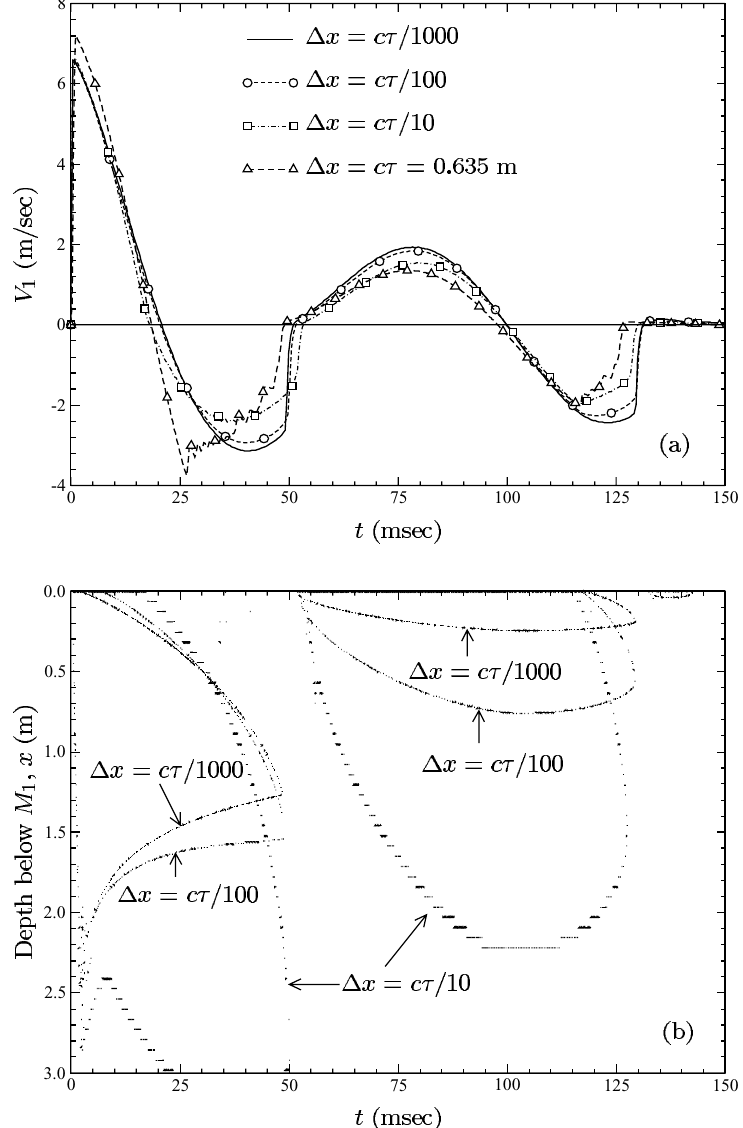
Fig. 13. (a) V 1 -response histories for M 2 /M 1 = 5 calculated with various ∆ x values. (b) Fluid-change-of-phase